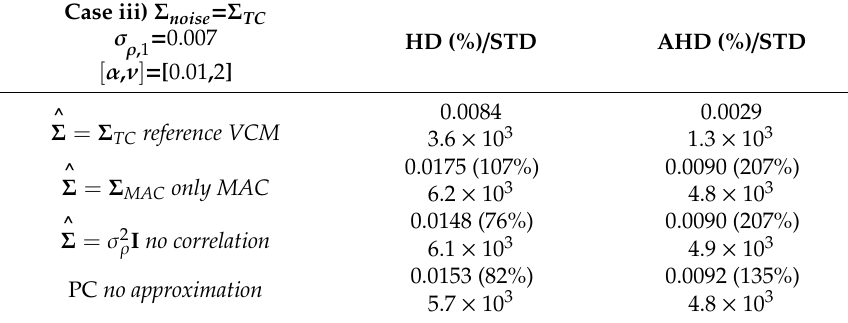
Table 3. Results of the Monte Carlo (MC) simulations for the case (iii) under gradual misspecification of the stochastic model. The Hausdor ff distance (HD), its averaged derivation (AHD) and the di ff erence HD − HD ref ratio defined as 100 HD